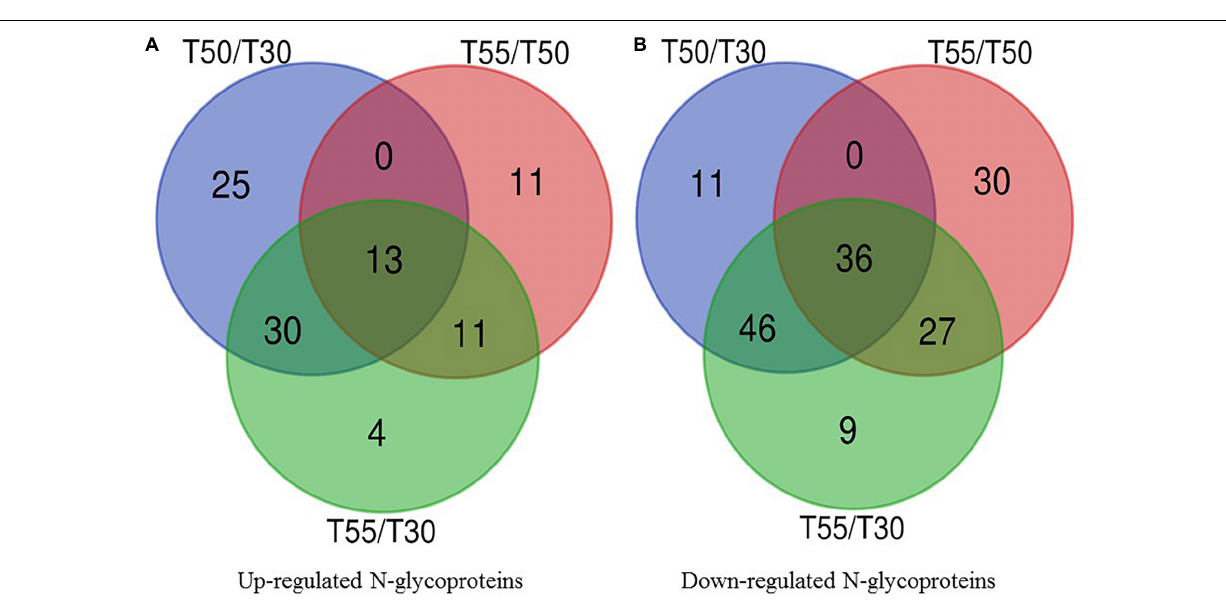
Frontiers in Microbiology |